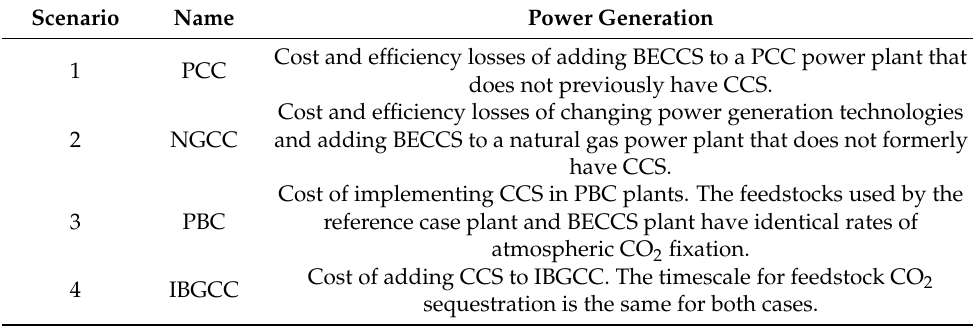
Table 2. Different reference cases of power plants used in the CAC equation and their